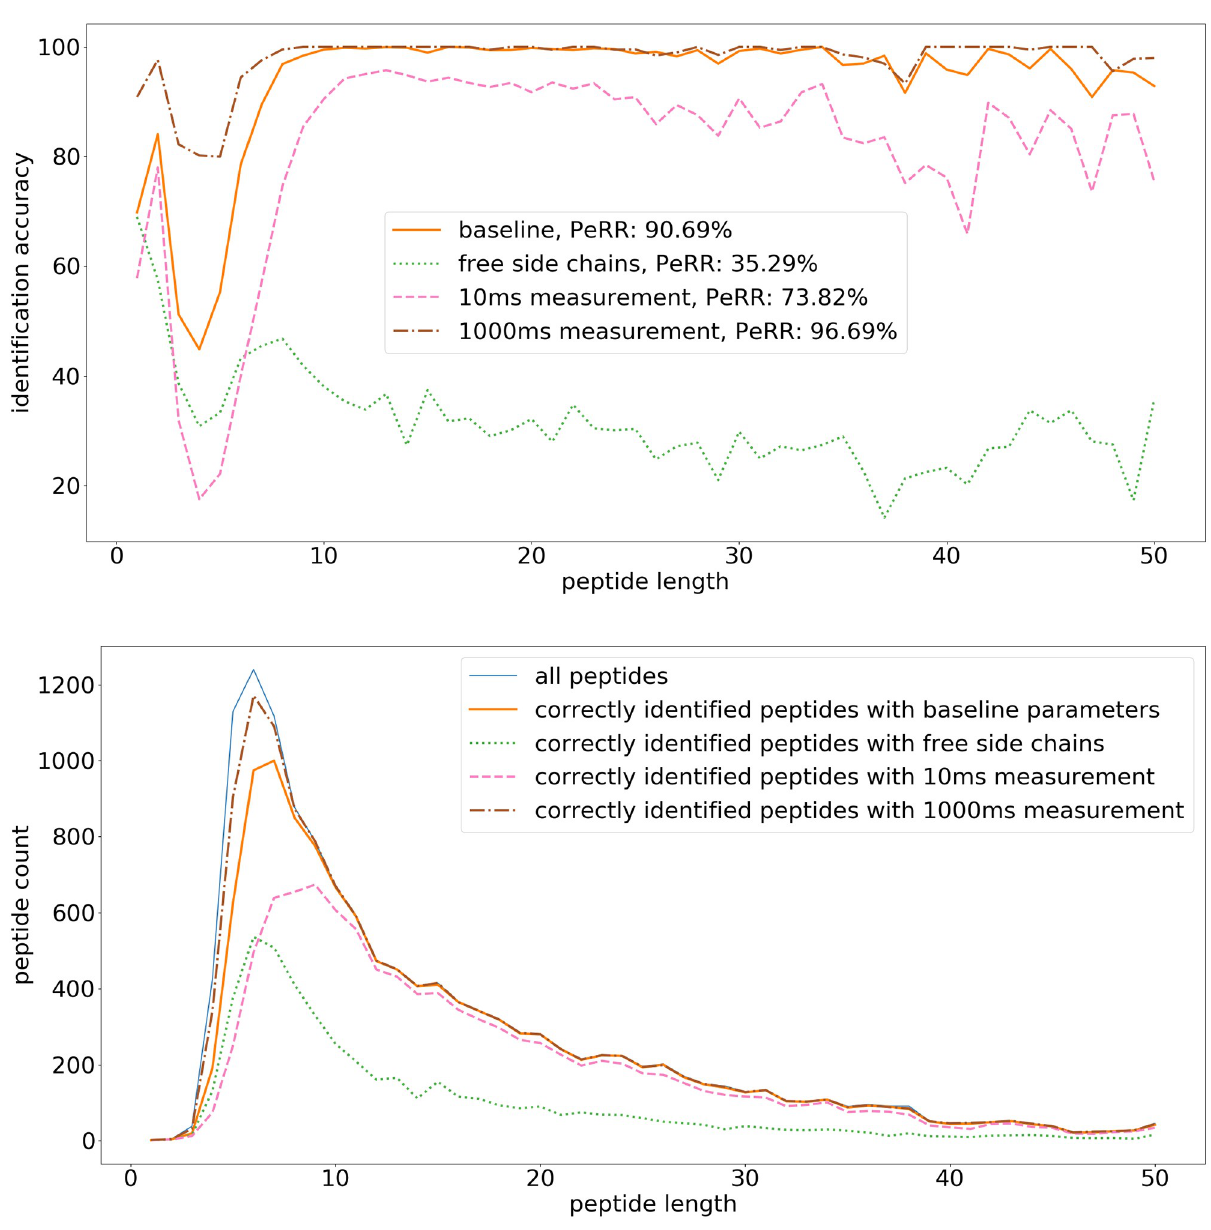
Fig 8. Peptide identification fraction: Baseline scenario, free side chains, and shorter and longer measurement time per amino acid. (top) The fraction of correctly identified peptides for each peptide length. The legend additionally contains the peptidome recovery rate (PeRR). (bottom) The total peptide count for each peptide length, and the count of correctly identified peptides. The simulation uses the following parameters: 100 ms ffiffiffi p measurement time per amino acid, pH 2.5, shielding factor exp ð(cid:0) 0 : 2 Þ , initial SNR 10, and bound side chains, i.e. additional molecules are attached d to the side chains, and no side chain signal is generated. In these simulations three variants on this baseline scenario are also included: (1) free side chains is the scenario of unbound side chains that can freely emit a signal, (2) the measurement time per amino acid is reduced to 10 ms instead of 100 ms, and (3) the measurement time per amino acid is increased to 1000 ms instead of 100 ms. when identifying proteins based on their N-terminal tryptic peptides corresponds with a unique PRR of 100% and a PRR of 65.42% for this data set. The results show that blocking side chains, longer measurement times per amino acid, weaker shielding and a higher SNR all result in a higher peptide and proteome recovery rates. In particular, blocking side chains